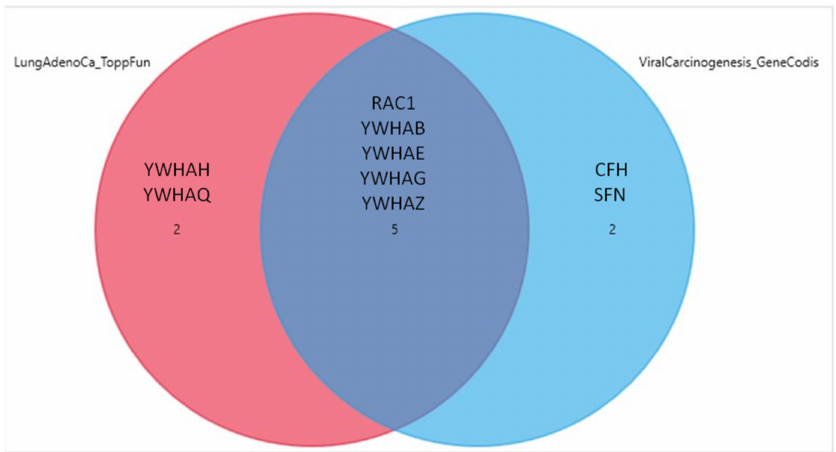
Figure 2. Venn diagram demonstrating that te gene overlaps between the lung adenocarcinoma and viral carcinogenesis ontologies, as retrieved from ToppFun and GeneCodis, respectively. Out of the seven genes over-represented in each annotation, five genes were common, as shown in the